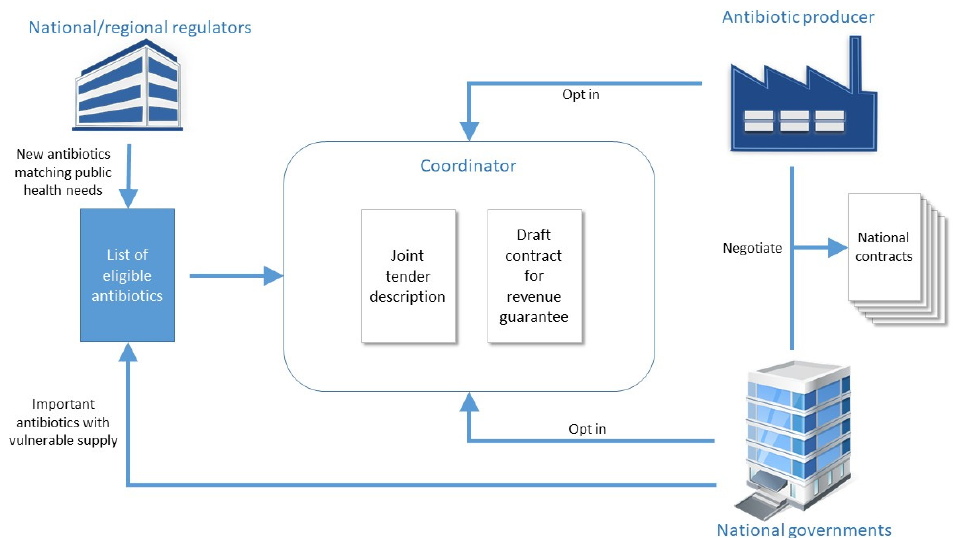
Figure 1. Potential multinational pull incentive based upon principles of the Swedish incentive.